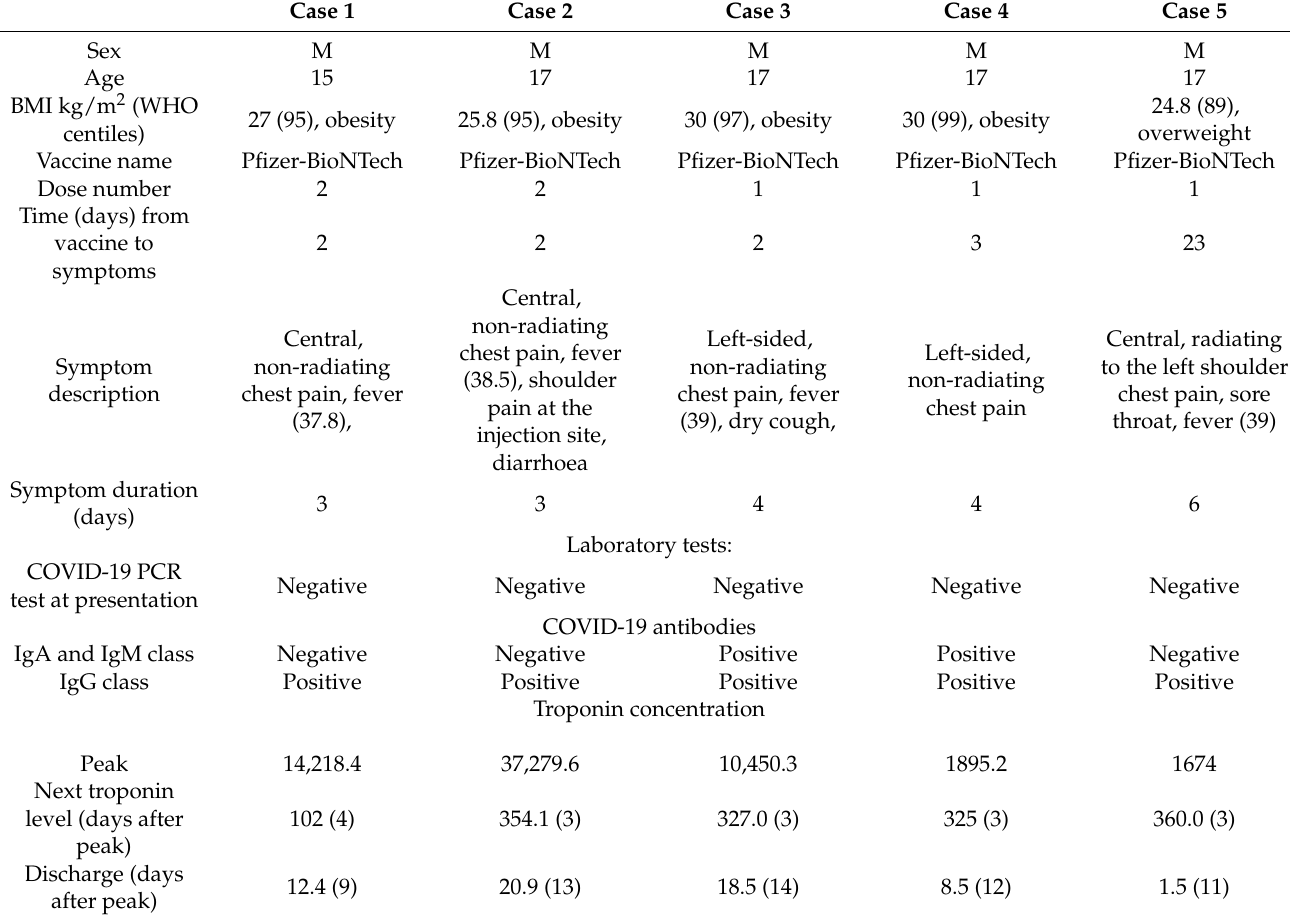
Table 1. General information, laboratory tests, treatment, length of hospital